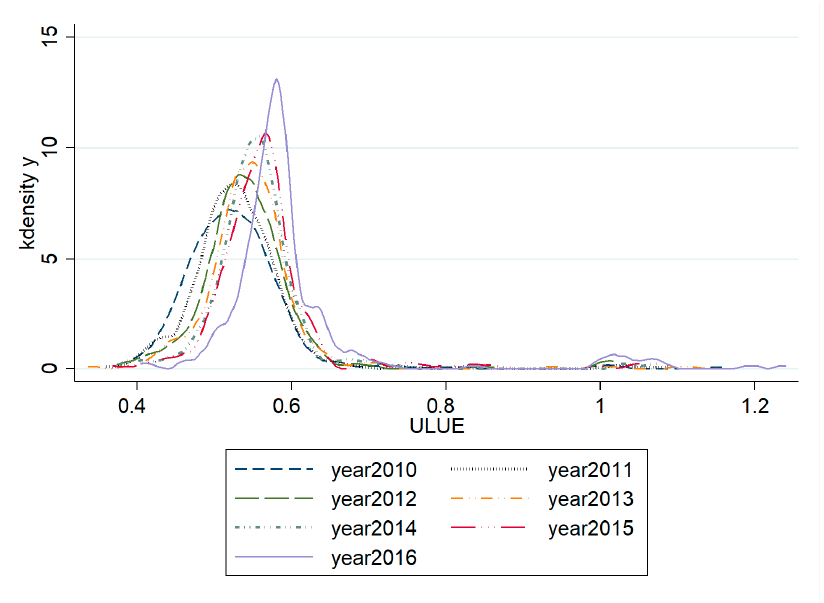
Figure 3. Kernel density estimation of ULUE in China during 2010–2016.